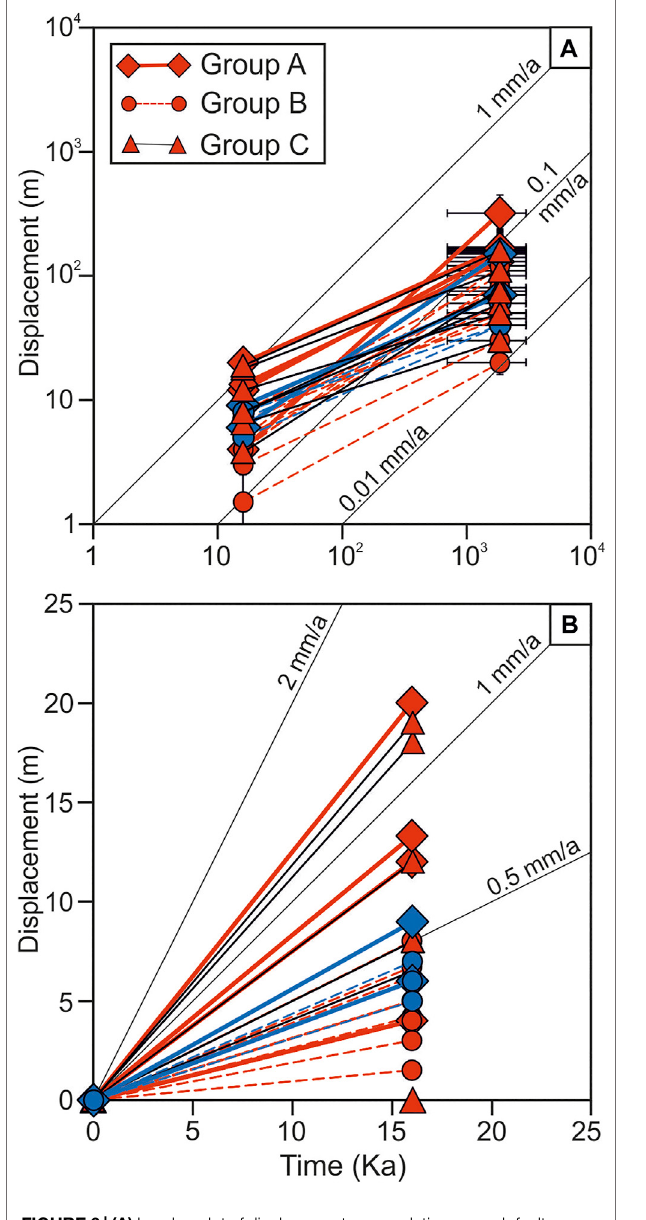
FIGURE 6| (A) Log-log plot of displacement accumulation on each fault over the last 0.7 – 3 Ma. (B) Plot of displacement accumulation on individual faults for each island over the last 16 ± 2 ka. Fault displacements on Kythira and Antikythira are highlighted red and blue, respectively.